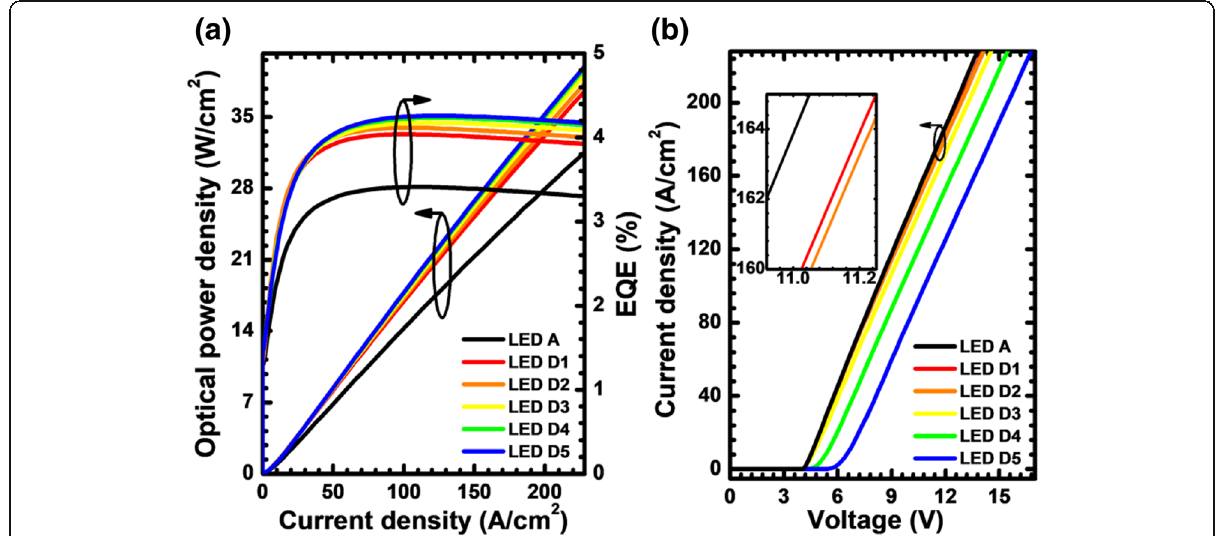
Fig. 10 a Optical output power density and EQE as a function of the injection current, b current-voltage characteristics for LEDs A, D1, D2, D3, D4, and D5. Inset figure shows the zoom-in current-voltage